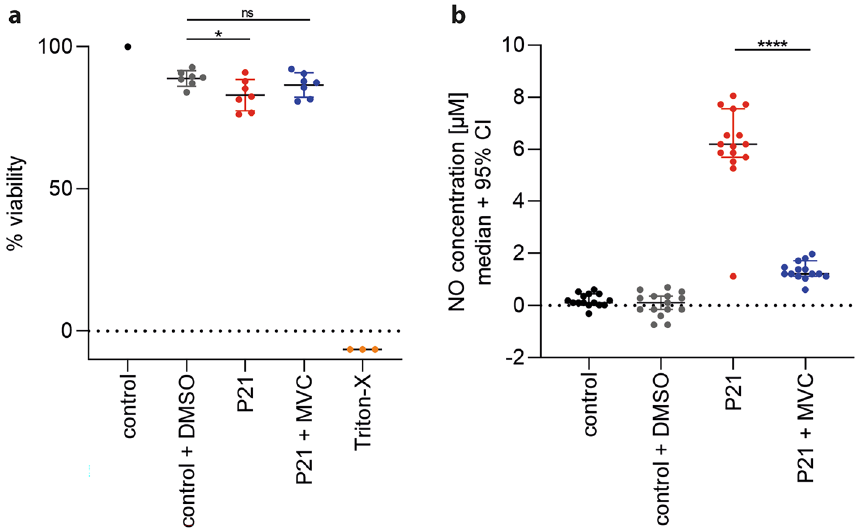
Figure 1. Effect of MVC in vitro. To determine whether MVC affected viability of the cells, the viability of the control group (black) was considered as 100% and used as reference for calculation. However, since MVC was dissolved in DMSO, we also assessed whether DMSO affected the viability negatively, as shown in gray (n = 7). 3% Triton-X (orange) (n = 3) was used a positive control for total cell mortality. ( a ) Results showed that P21 stimulation alone (red) (n = 7) ( p = 0.02), but not with MVC treatment (blue) (n = 7), reduced cell viability compared to control group with DMSO. Further, MVC treatment significantly reduced NO concentration